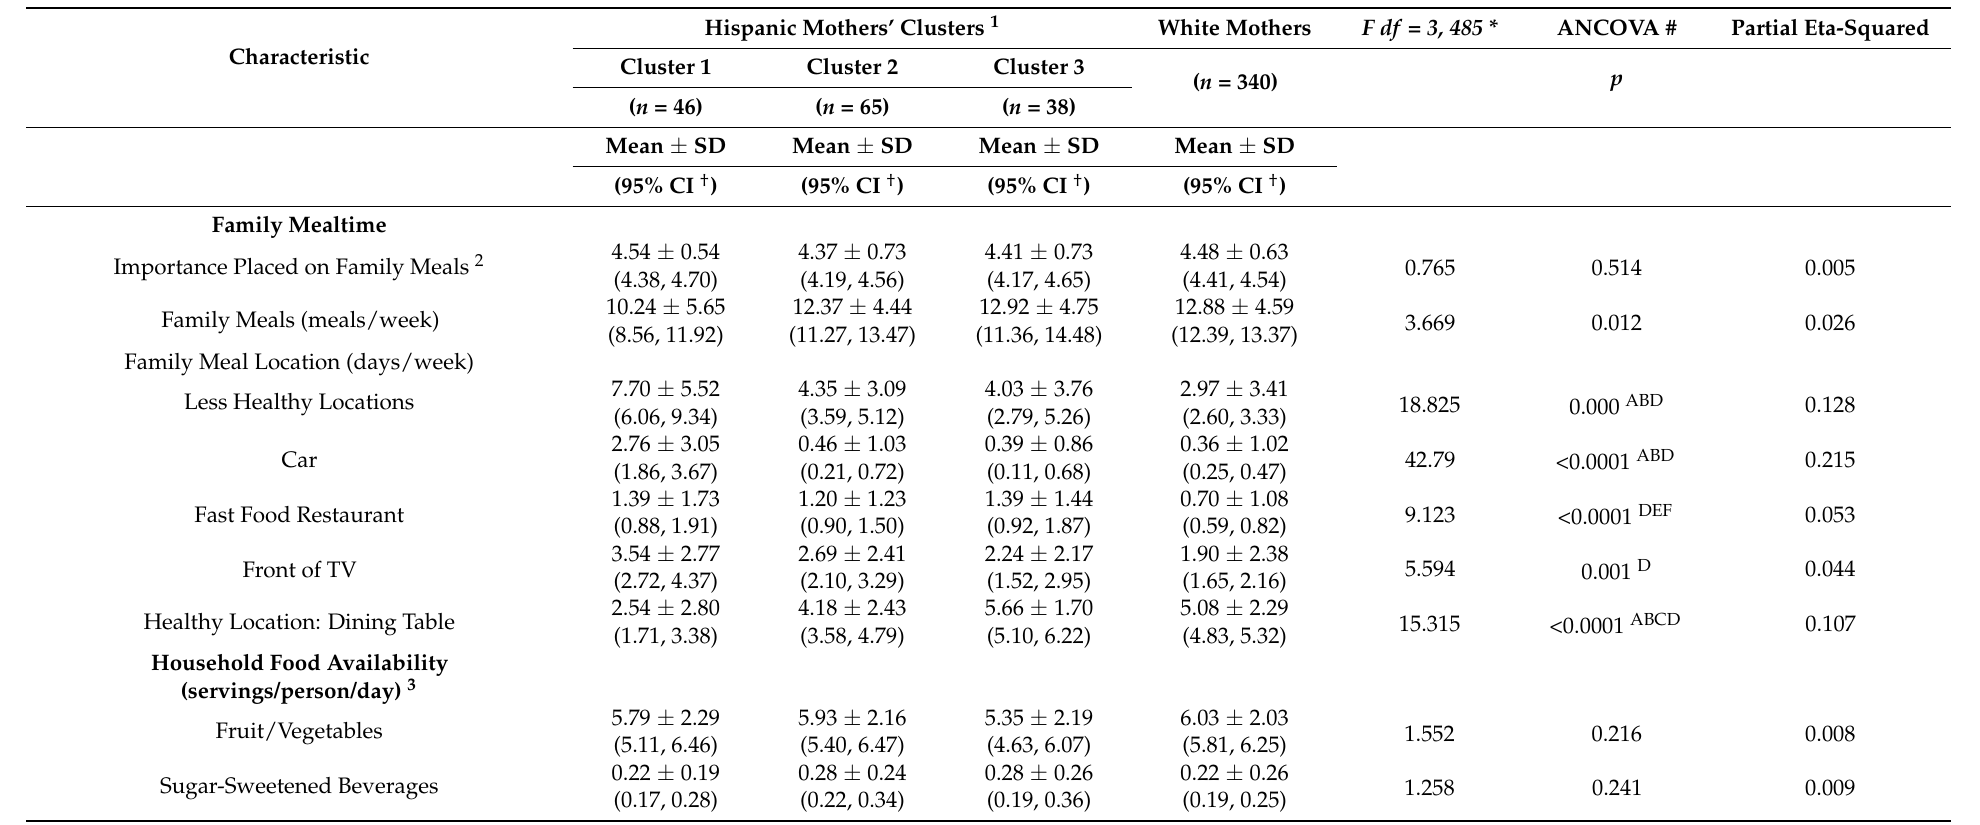
Table 5. Home Environment Characteristics ( n =